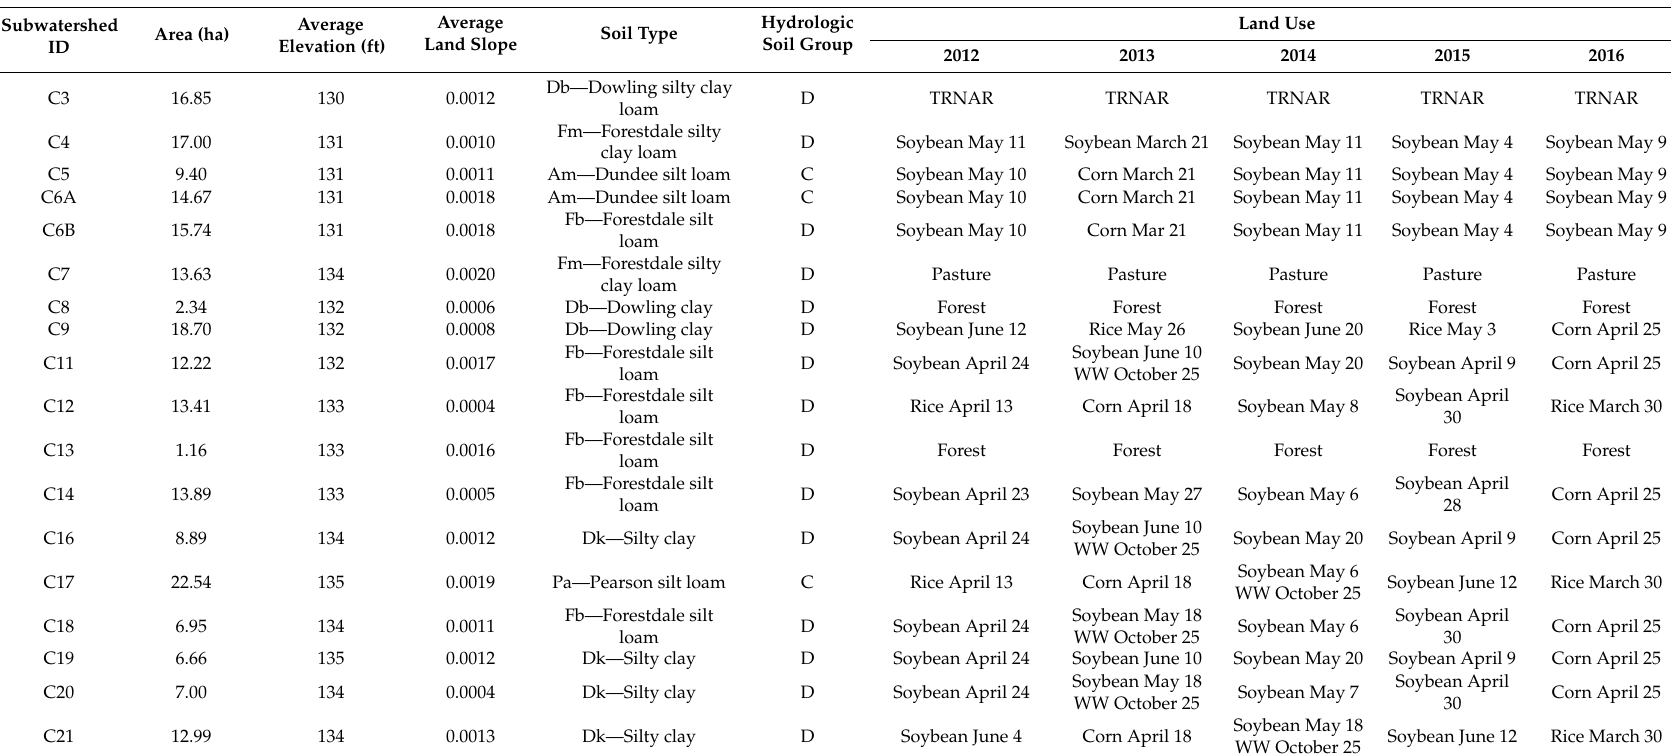
Table 1. Basic characteristics and land use including the planting dates of the subwatersheds.